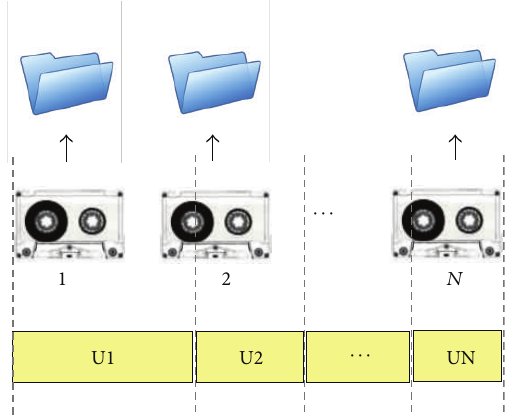
Figure8:Therelationbetweentheaudiodocuments(inthemiddle) and the preservation copies (on top) is always 1: 1. The relation between the latter and the fruition units (U1, U2, etc.) can be complex,whichisoftenthecasewitharchivesofrecordingsgathered on the field for linguistics and ethnomusicological